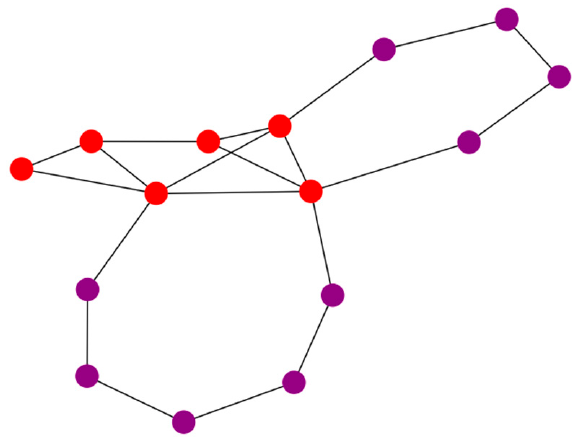
Figure 6. Metro network topology organized in two layers with nine metro-edge and six metro core nodes.